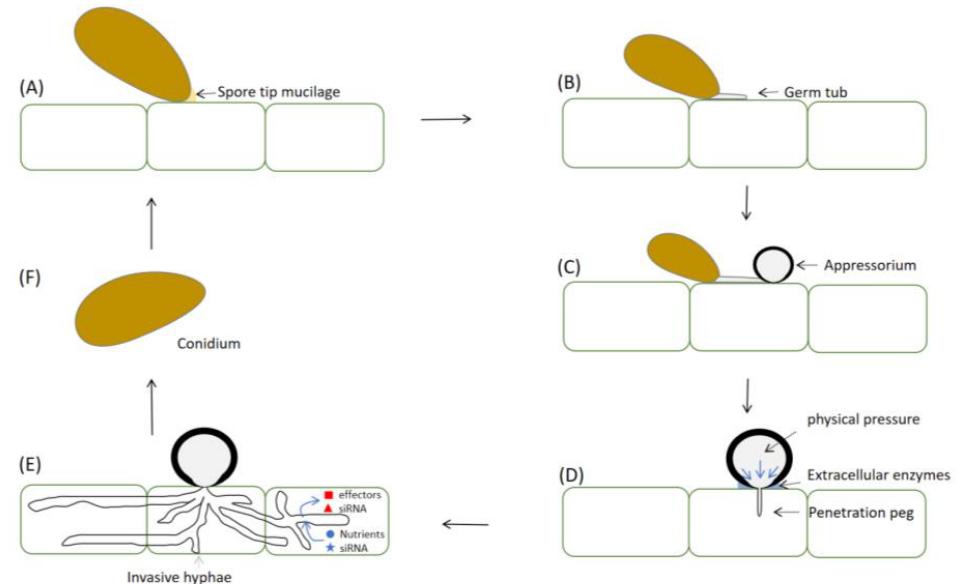
Figure 2. Concept of plant infection by appressorium-forming fungi. ( A ): A spore secretes an adhesive extracellular matrix that allows it to attach firmly to the host surface, then the infection begins. ( B , C ): Subsequently, the spore tapering end develops a single, polarized hypha, which grows along the host plant surface, and finally differentiates into an appressorium. ( D ): Formed appressoria adhere firmly to the host surface and subsequently secrete extracellular enzymes or produce physical force (or use a combination of both factors) to facilitate cuticle penetration. Cellular turgor is translated into mechanical force by penetration peg, forcing it through the leaf cuticle. ( E ): The pegs differentiate invasive hyphae to colonize rapidly epidermal and mesophyll tissues and secrete effectors and sequester nutrients from living host cells. The fungus ramifies intra- and intercellularly in susceptible host tissue upon penetration. Lesion formation is initiated with host cell death starting 4 to 5 days after infection. ( F ): The next generation of conidia is then produced.